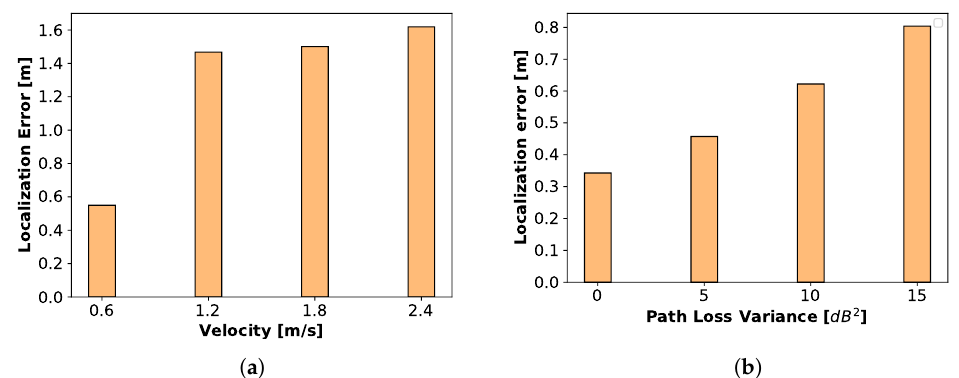
Figure 18. Average localization error as a function of ( a ) MN’s velocity, and ( b ) path loss